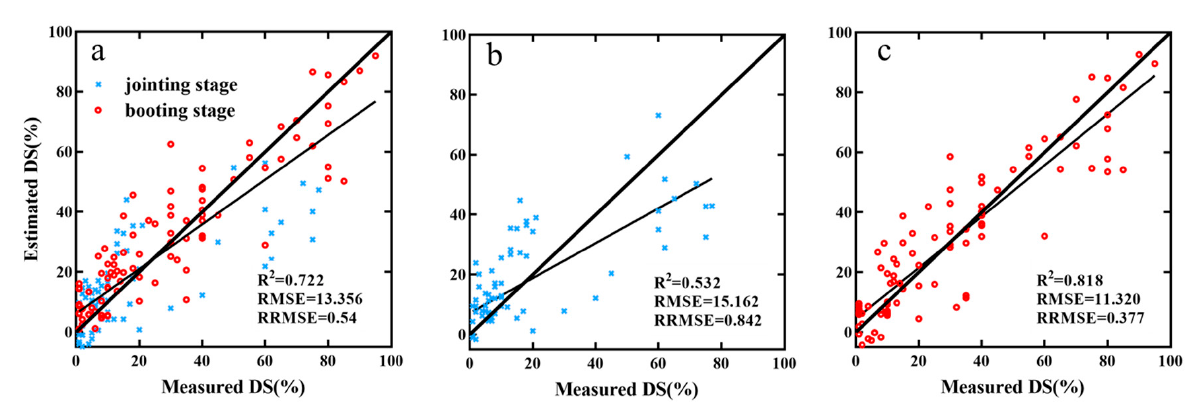
Figure 9. Comparison of measured and estimated wheat powdery mildew DS based on combined features of VIs & NDTIs, at both stages ( a ), jointing stage ( b ), and booting stage ( c ).